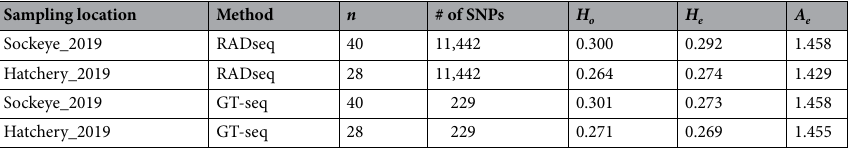
Table 3. Comparison of neutral RADseq 38 and GT-seq dataset diversity estimates including heterozygosity [observed ( H o ) and expected ( H e )] and effective number of alleles ( A e